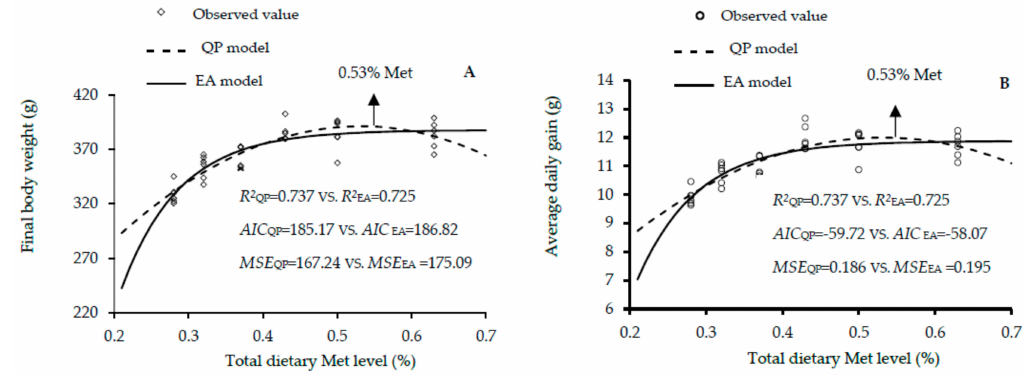
Figure 4. Regression models plot of growth performance as a function of total dietary Met level (0.28%, 0.32%, 0.37%, 0.43%, 0.50%, and 0.63% Met) of male slowly growing yellow-feathered chickens between 0 and 30 days of age. Correlation coe ffi cient ( R 2 ), Akaike information criteria (AIC) and mean squares error (MSE) are indicators used to evaluate fitness of models. ( A ) The optimum response arrow pointing at 0.53% Met by the best fitting model. ( B ) The optimum response arrow pointing at 0.53% Met by the best fitting regression